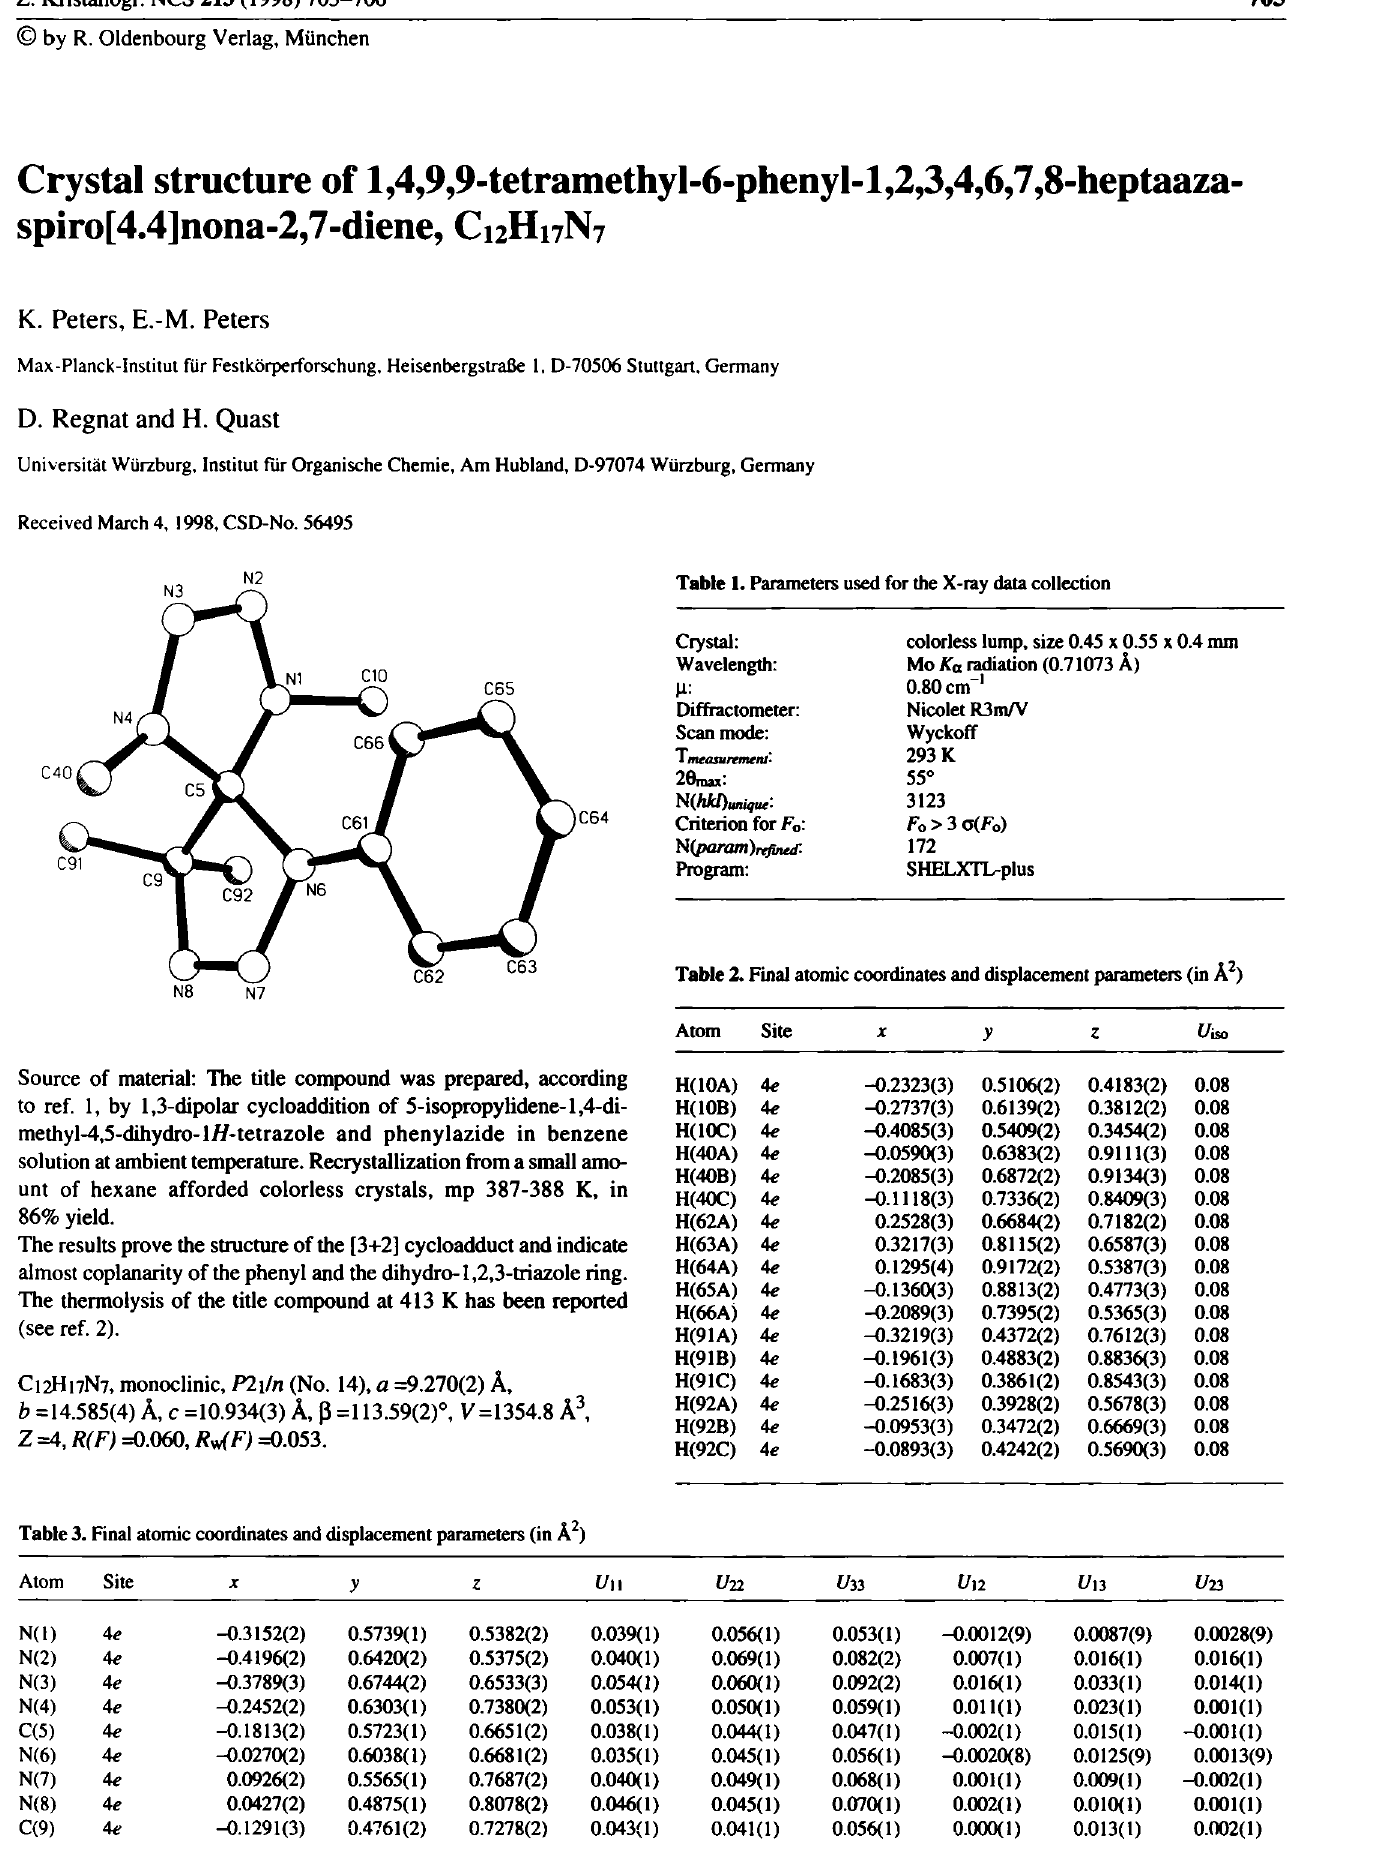
Table 1. Parameteis used for the X-ray data collection Crystal: